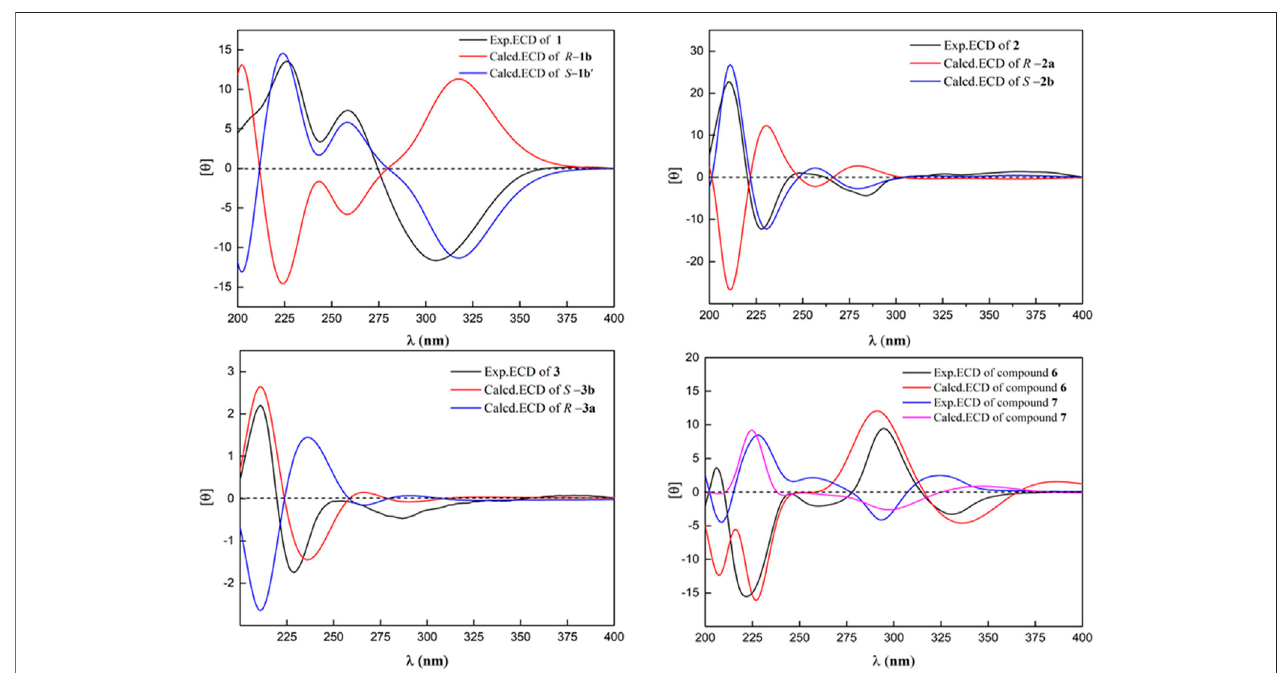
FIGURE 4 | Calculated and experimental ECD spectra of 1 – 3 and 6 – 7 .